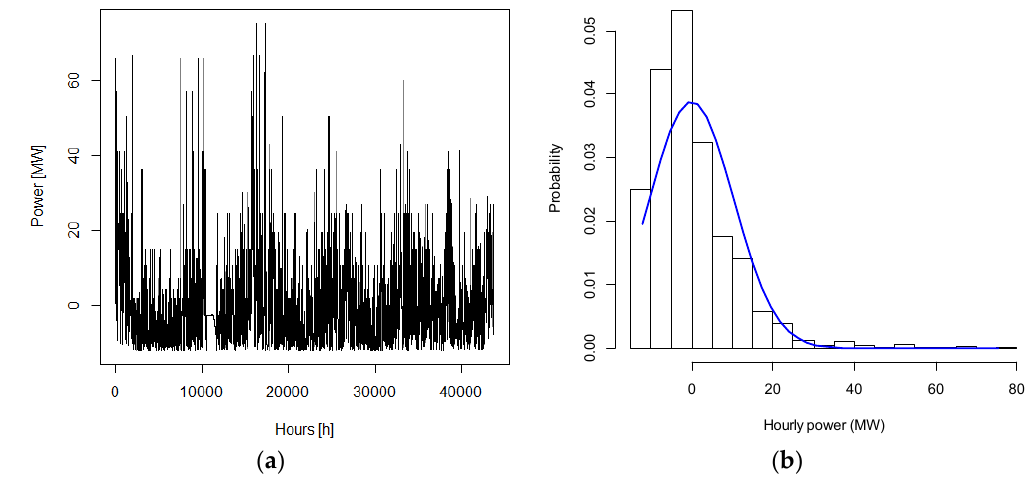
Figure 7. ( a ) Difference between generation and extracted limit capacity (MW); and ( b ) Histogram and pdf of the difference between generation and extracted limit capacity.